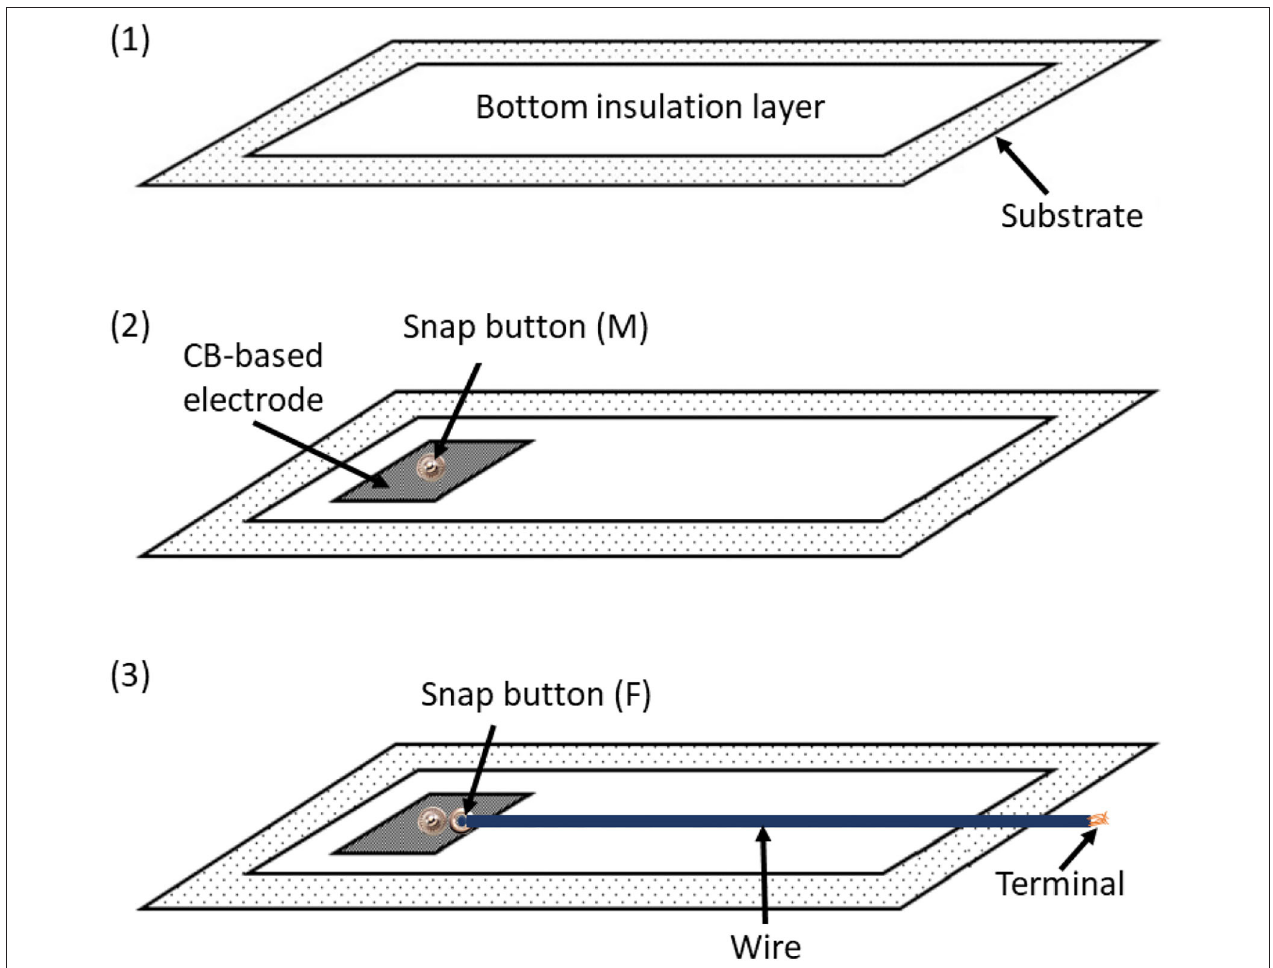
FIGURE 3 | The coupling between conductive and insulating materials designed for the ATTICUS S-WEAR: (1) the bottom insulation layer, (2) the male snap button immersed into the CB-based electrode, (3) the female snap button linked by a common wire to the terminal for the electronic unit. The wire is covered by insulating